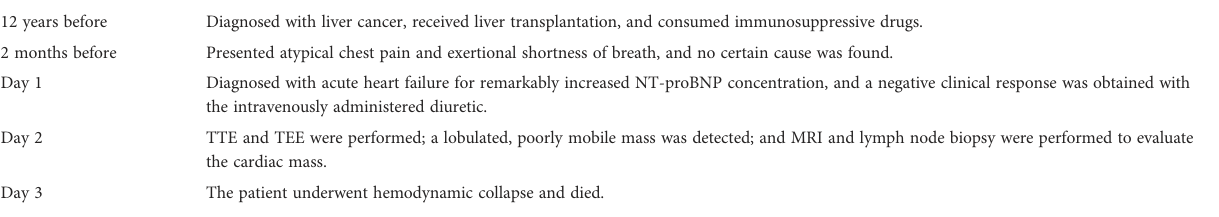
TABLE 1 Timeline of the case: The crucial events in this case. Timeline of the